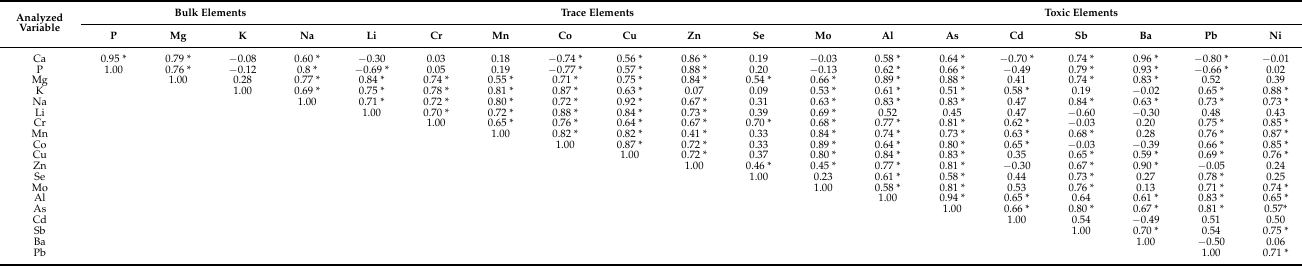
Table 2. The relationship between minerals in the examined tissues of fallow deer in total ( N = 24).